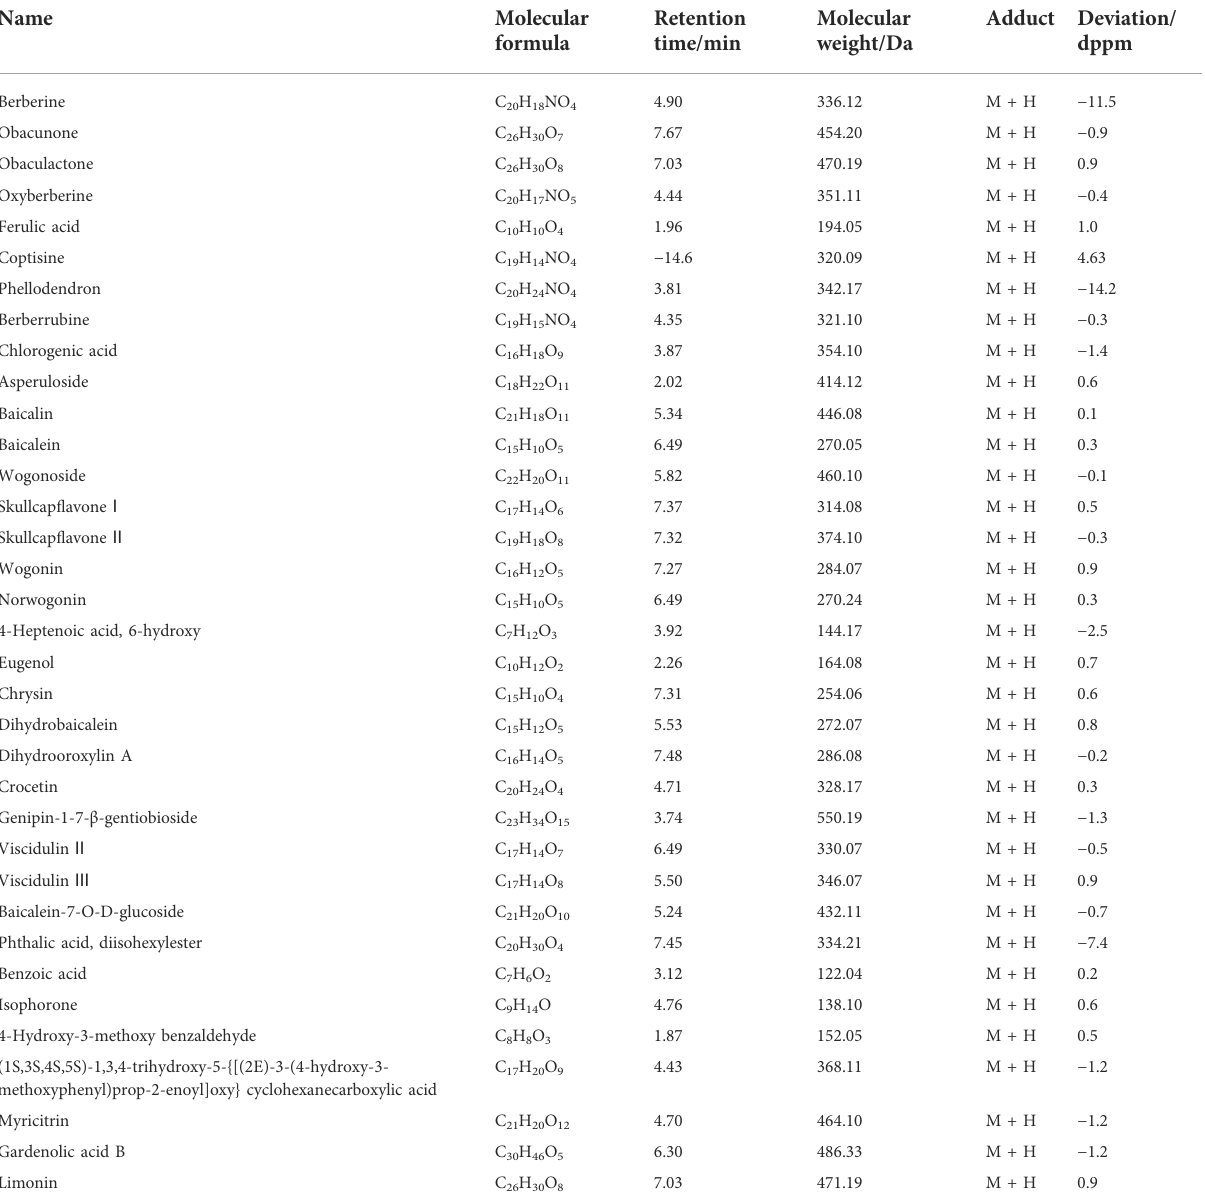
TABLE 2 Compounds in